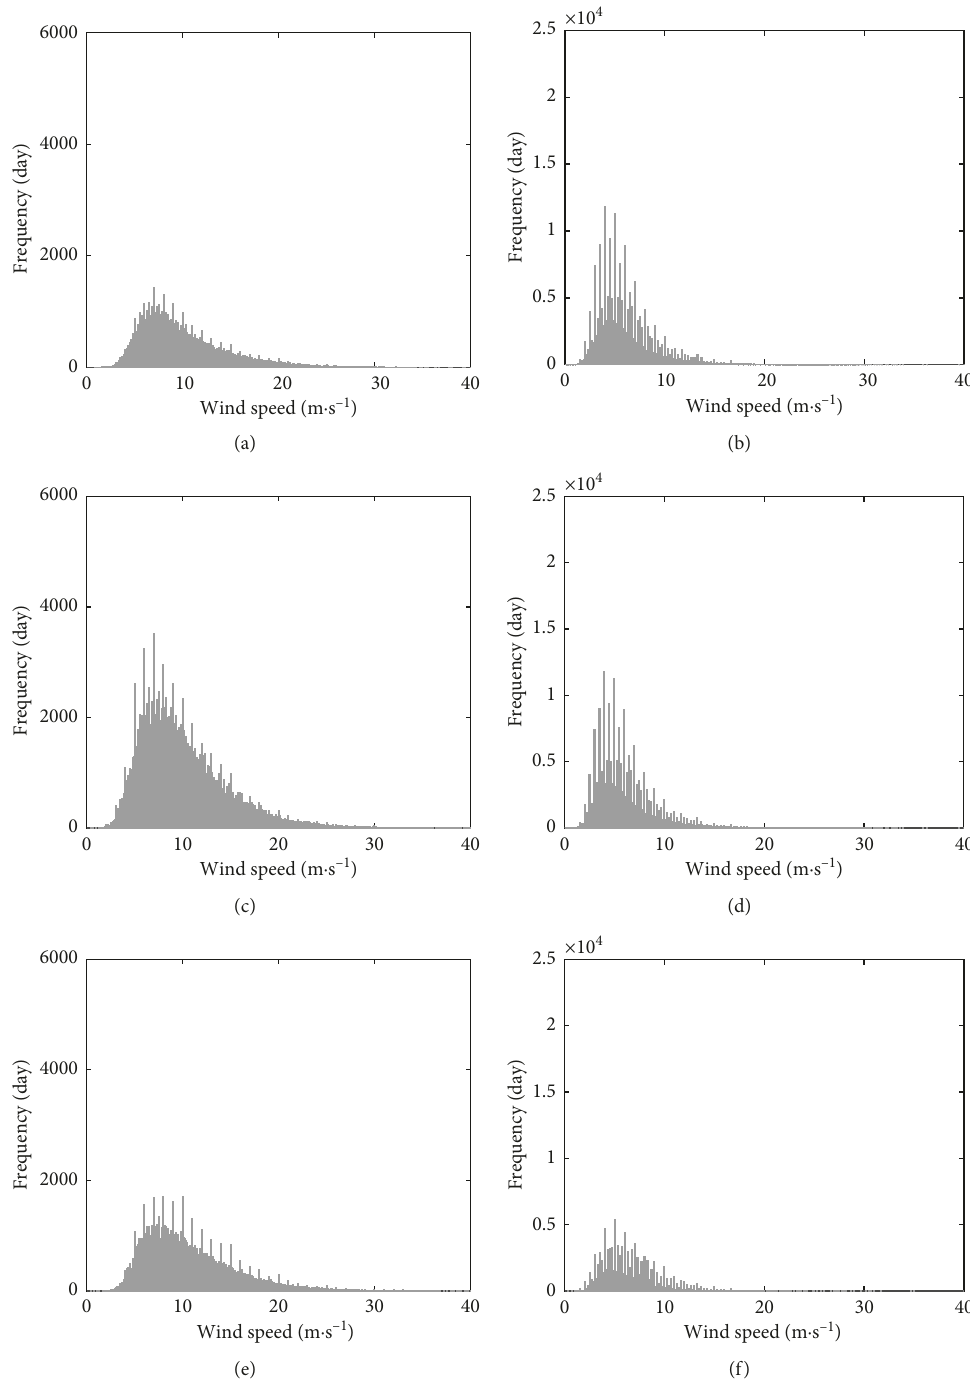
F IGURE 6: Daily maximum instantaneous wind speed (a, c, e) and daily maximum wind speed (b, d, f) frequencies in the western coastal (top), southern coastal (middle), and eastern coastal areas